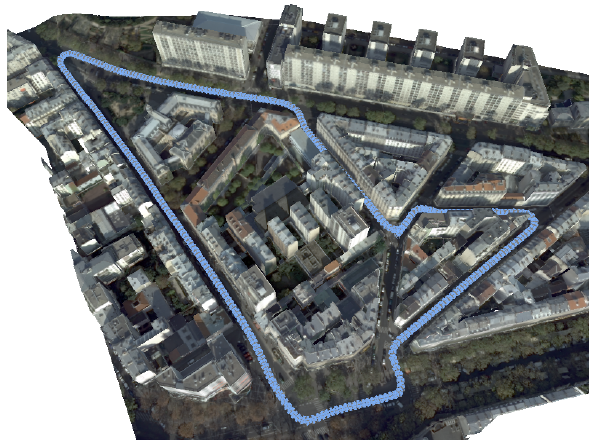
Figure 4: Visualization of the 5344 images used in our experi- ments.